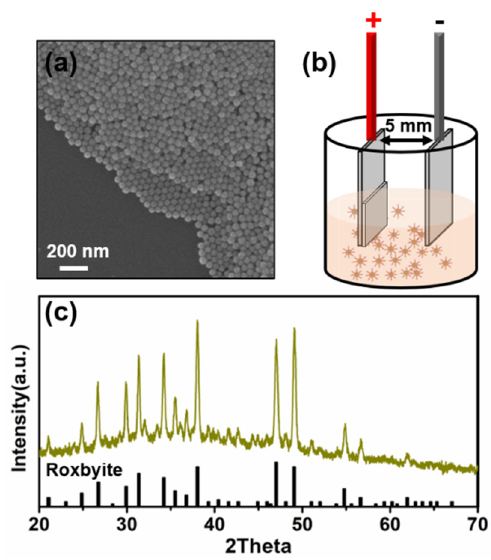
Figure 1. Characterization and electrophoretic deposition (EPD) of the fabricated Cu 2-x S nanoparticles (NPs): ( a ) SEM image; ( b ) schematic EPD set-up; and ( c ) XRD pattern, with the black bars underneath corresponding to the reference data for the roxbyite phase (JCPDS #23-0958).